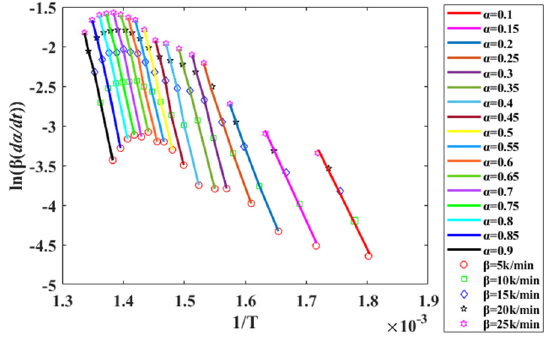
Figure 1. ln(𝛽𝑑𝛼/𝑑𝑇) versus 1/T fit line for equal conversion rates at multiple heating rates. Figure 1. ln ( β d α / dT ) versus 1 / T fit line for equal conversion rates at multiple heating